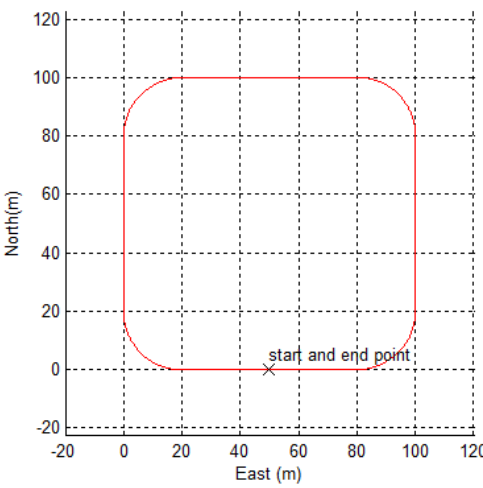
Figure 1. The top view of the vehicle trajectory